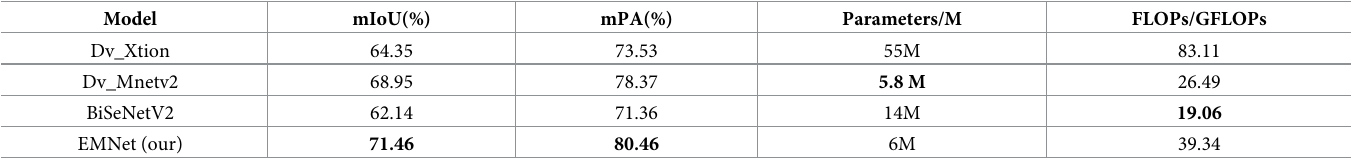
Table 3. Segmentation performance of different models on the UAVid test